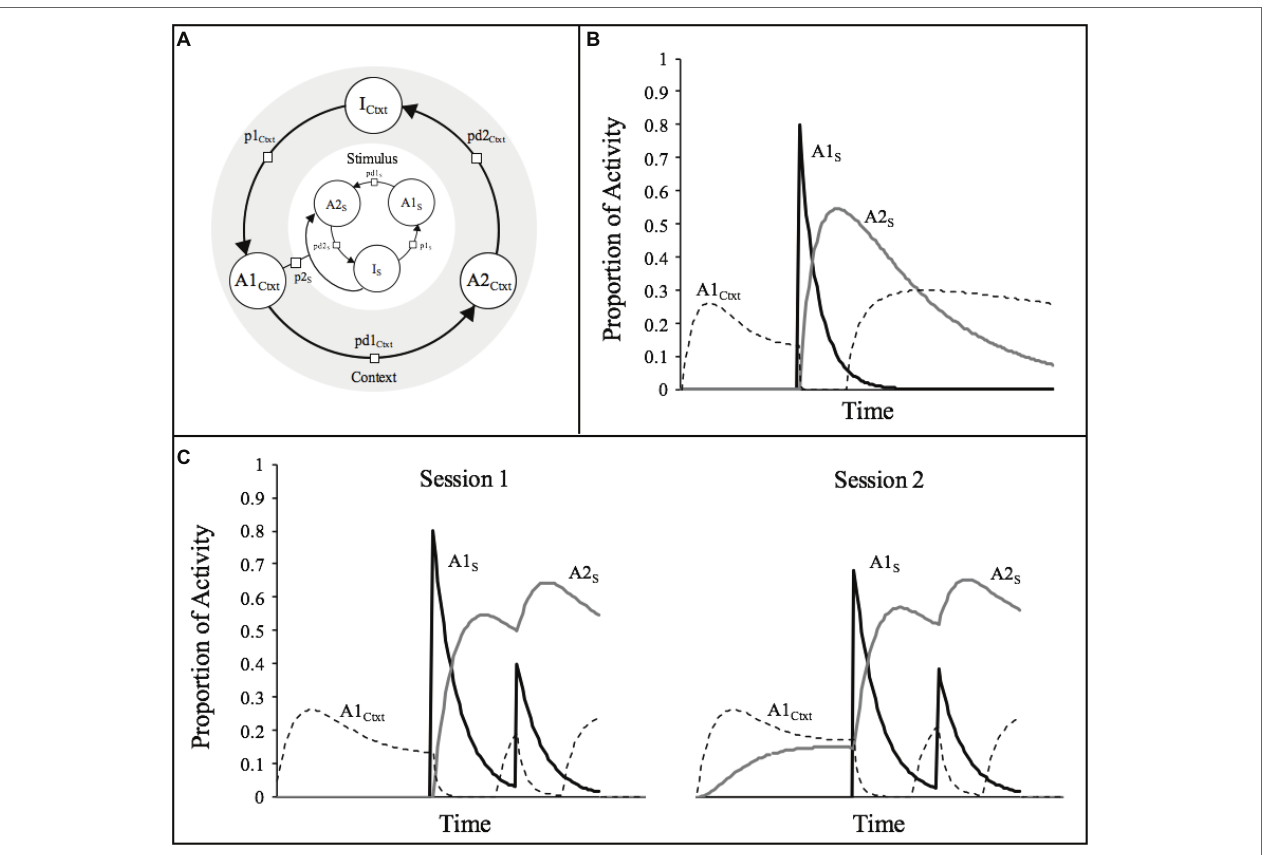
FIGURE 2 | (A) A representation of the context-stimulus relationships assumed by SOP. (B) Courses of activity for a typical stimulus (s; duration = 1 moment, p 1 S = 0.8, pd 1 S = 0.1, pd 2 S = 0.02) and the context ( p 1 Ctxt = 0.05; pd 1 Ctxt = 0.1; pd 2 Ctxt = 0.02) according to SOP rules of activity. (C) Simulations of the theoretical processes involved in two training sessions with two presentations of a 1-moment stimulus within the